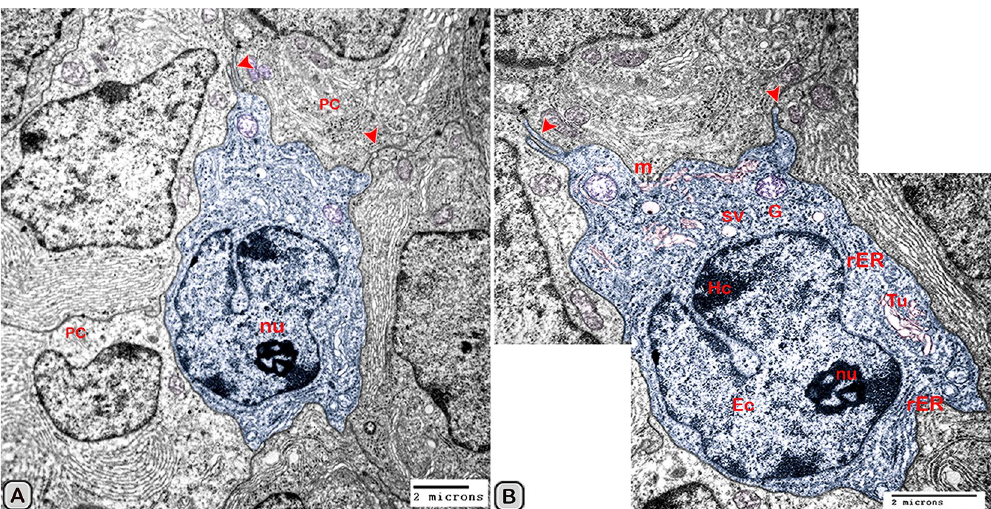
Figure 15. Digitally colored transmission electron microscope images of the free movable immature dendritic cells. (A,B) The nucleus was euchroamtic (Ec) and deeply indented with a distinct nucleolus (nu). (B) The cytoplasm consisted of well-developed rER, a great amount of the dense granules (G), secretory vesicles (SV) a moderate number of mitochondria (m) and ill-developed tubule-vesicular system (Tu). The cell processes were short and thin or thick (red arrowheads). HC heterochromatin, EC euchromatin, PC principal cell.